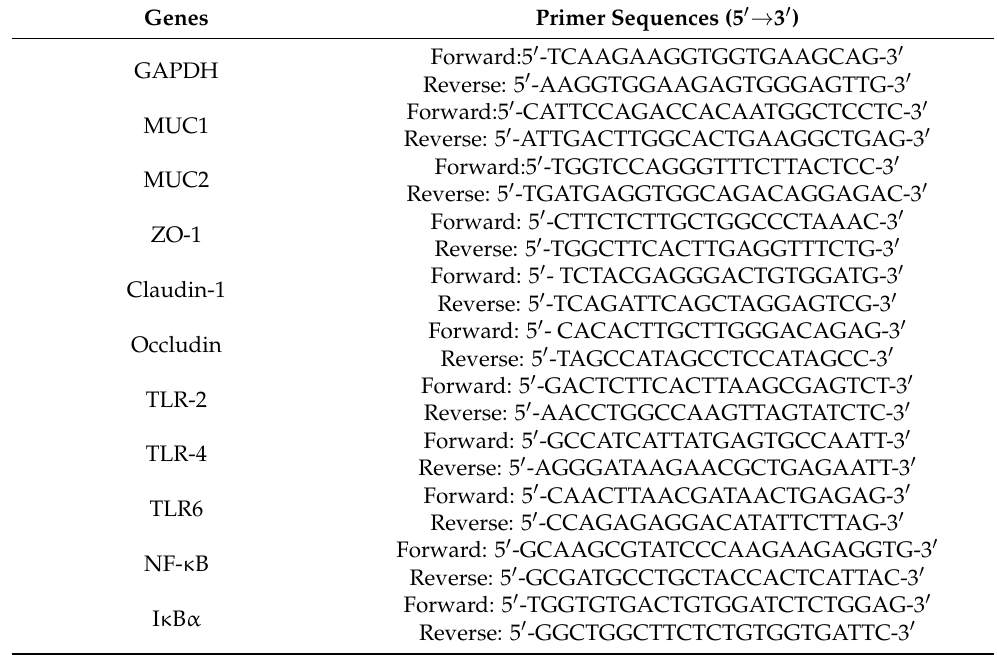
Table 3. Primer sequences used in real-time